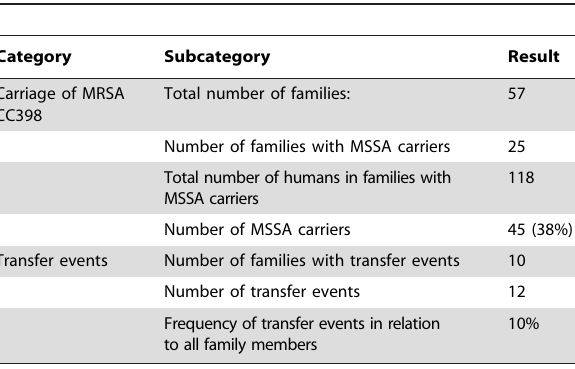
Table 5. Nasal carriage of methicillin susceptible S. aureus (MSSA) among families living on pig farms.